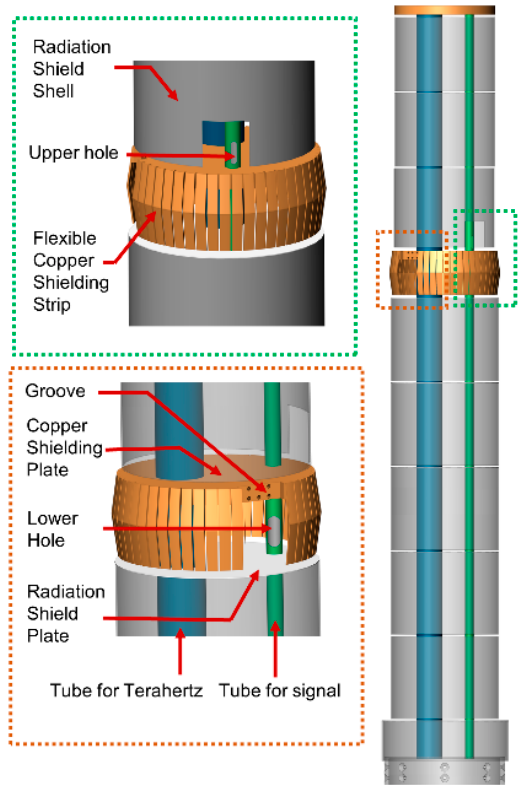
Figure 2. Schematic diagram of the multilayer radiation shielding insert.